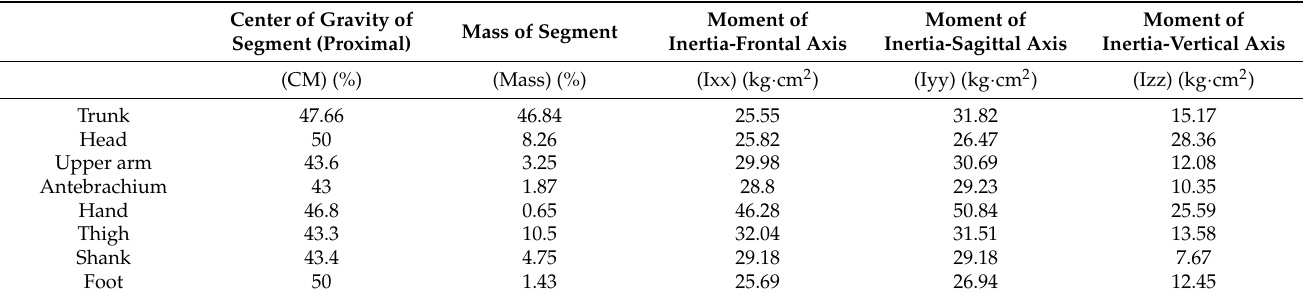
Figure 1. Experiment setup process. ( a ) Twenty one optical capture reflective markers. ( b ) Experimental frame. Table 1. The limb segment parameters.